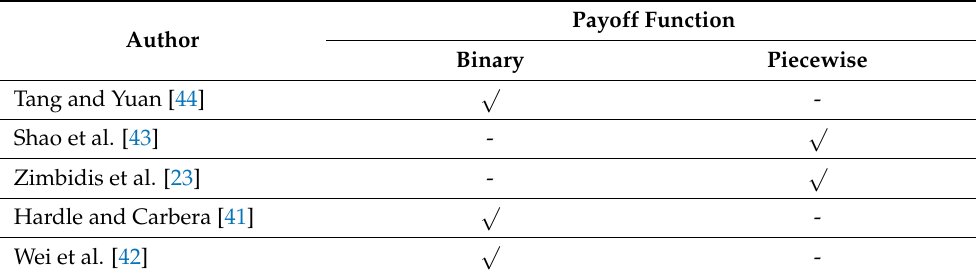
Table 9. Summary of the payoff function models used in primary